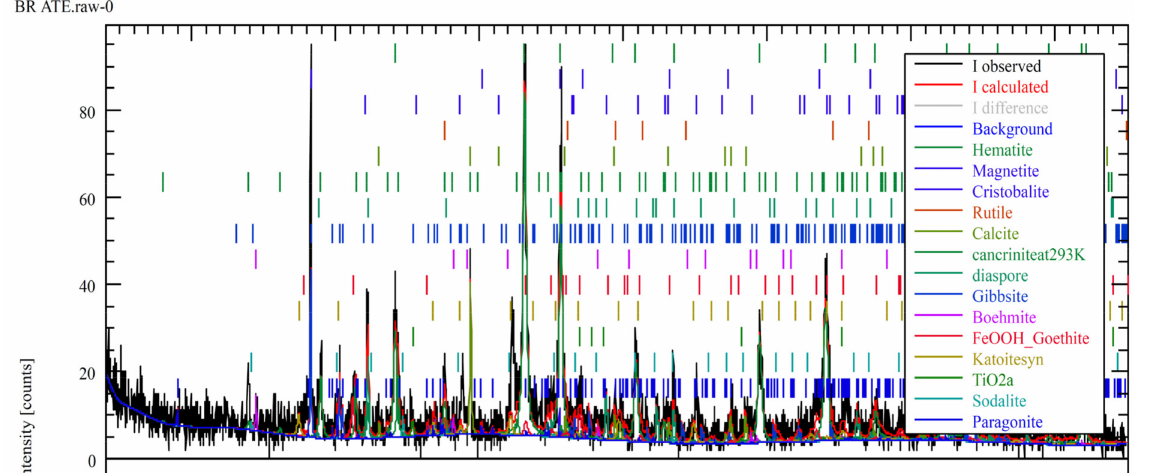
Figure 2. Phases of BR from